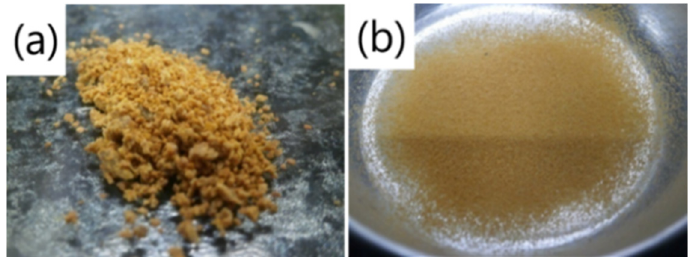
Figure 1. Chitosan–mangostin–alginate dry particles: ( a ) before grinding and ( b ) after grinding with particle size < 100 µm.